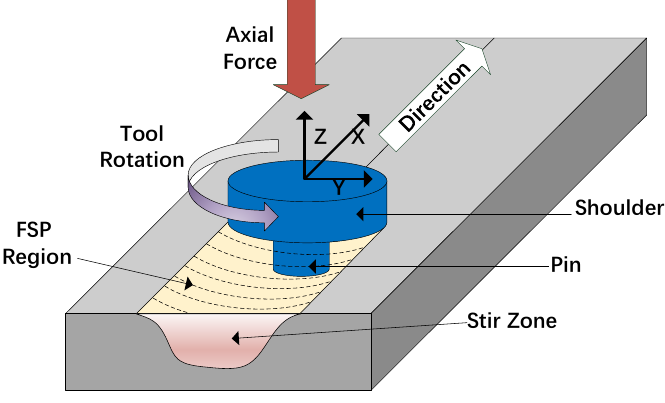
Figure 1. Schematic diagram of friction stir processing (FSP).